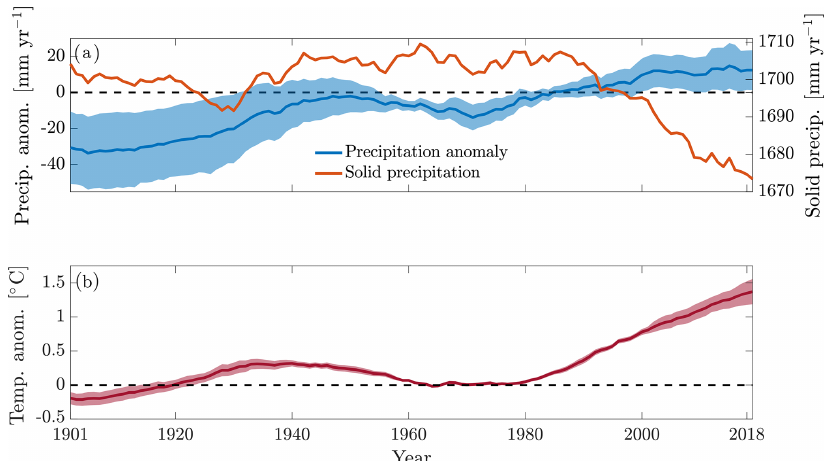
Figure 8. (a) Global mean annual precipitation anomaly relative to 1961–1990 and amount of solid precipitation. (b) Global mean annual temperature anomaly relative to 1961–1990. The shadings show ± 1 σ , i.e., standard deviation among meteorological forcing data sets. Values in both panels are 31-year moving averages of the ensemble mean at glacier tongue locations and weighted by glacier area, except for the graph of solid precipitation, which is based on the mean forcing input data. Since scales of computed solid precipitation might vary between ensemble members depending on model parameters (see Eqs. 3 and 4), the computation of an average, especially with a temporally varying number of ensemble members, is less meaningful. Values of the CERA20C forcing are excluded from the ensemble mean (see Sect. 3.1.1).